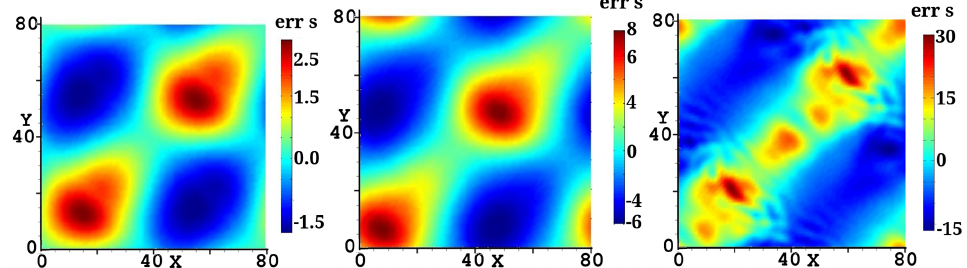
Fig. 6. Distribution of the errors of the simulated top surface elevation s (m) for the time-dependent ice-sheet flow experiment using the grid of resolution 80 × 80 × 20. From left to right: at 100, 300, and